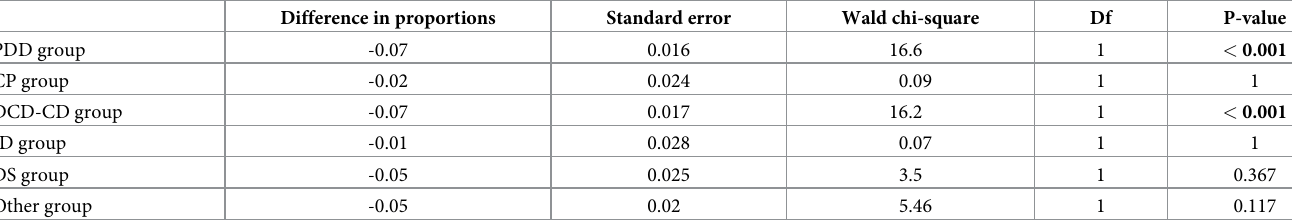
Factors associated with the cancellation rate in the AD/HD group The use of OROS-MPH or antipsychotics was significantly associated with a lower cancellation rate in the AD/HD group. No other factors showed an association with the cancellation rate in this specific group (Table 4). However, only OROS-MPH was significantly associated with a lower cancellation rate in the AD/HD group in a subgroup analysis including only patients who were � 4 years old at the first visit (S1 Table). None of the factors was significantly associ- ated with a lower cancellation rate in another subgroup analysis including only patients who were � 6 years old at the first visit (S2 Table). Table 3. Comparison of cancellation rate between patients with AD/HD and the other